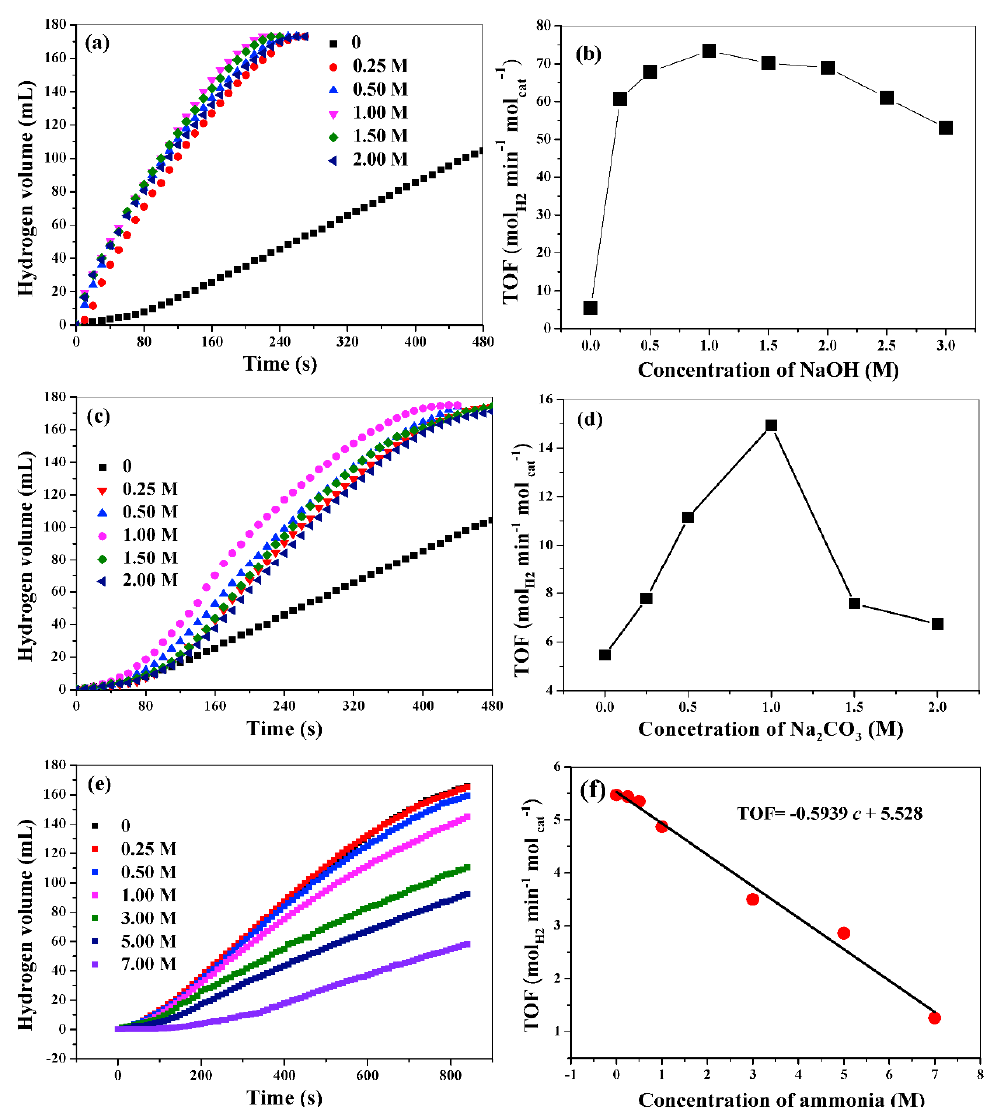
Figure 7. Hydrogen release curves in the presence of NaOH ( a ), Na 2 CO 3 ( c ), and NH 3 · H 2 O ( e ), and the corresponding TOF values at different concentrations ( b , d , f ).